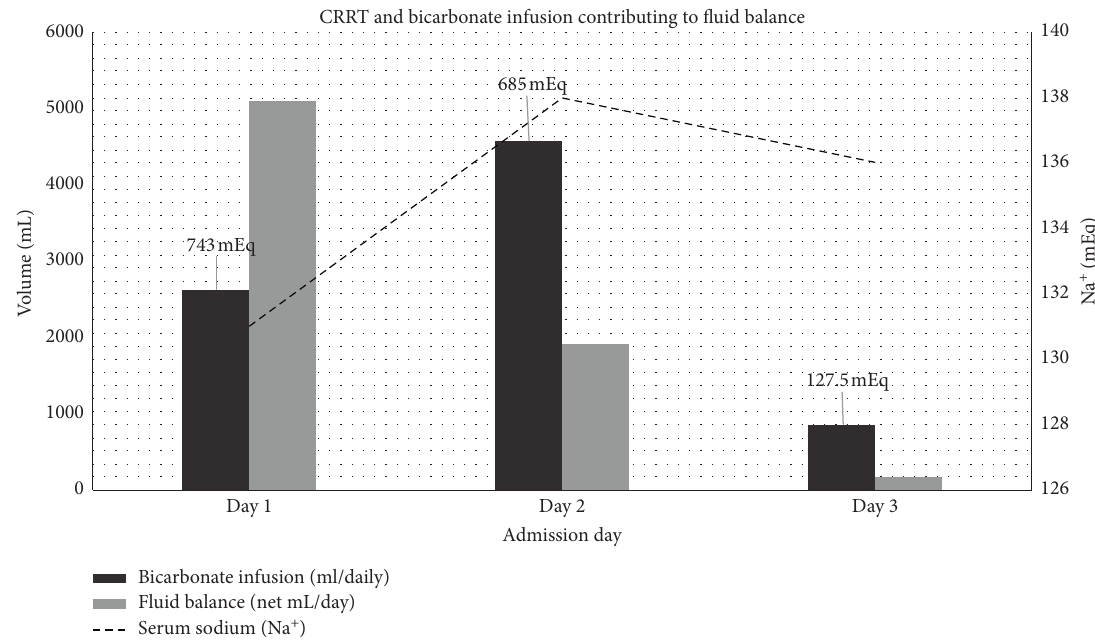
Figure 3: CRRT and bicarbonate infusion contributing to fluid